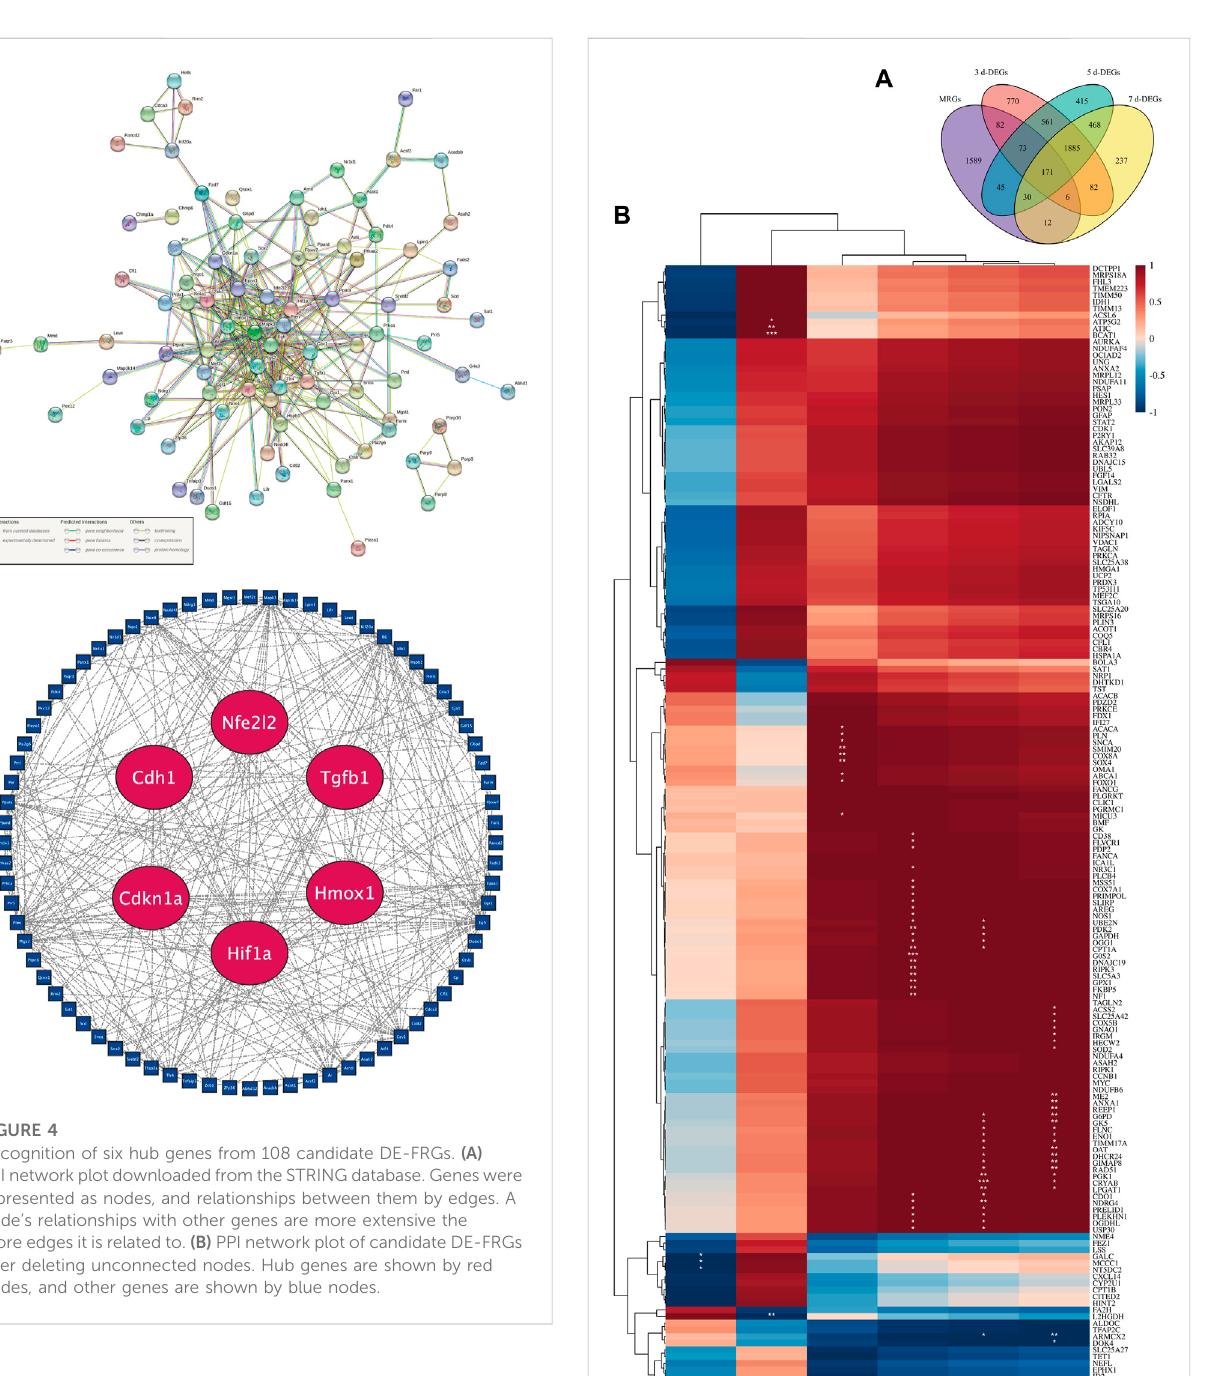
genes was validated in other pertinent datasets with the same conditions, and the veri fi cation fi ndings were shown as volcano plots. The 1-day group, 4-day group, 7-day group, and 14-day group results from data set SRP113121 are displayed in Figures 6C – F, respectively; the 4-day group and 7-day group results from data set GSE162548 are displayed in Figures 6G,H, respectively. In the fi rst data set, the hub genes Nfe2l2, Tgfb1, and Cdkn1a showed substantial upregulation at all four time periods. But at the other hand, the upregulation of Hif1a and Hmox1 was only observed in the 7-day and 14-day groups. In the second data set, all six hub genes